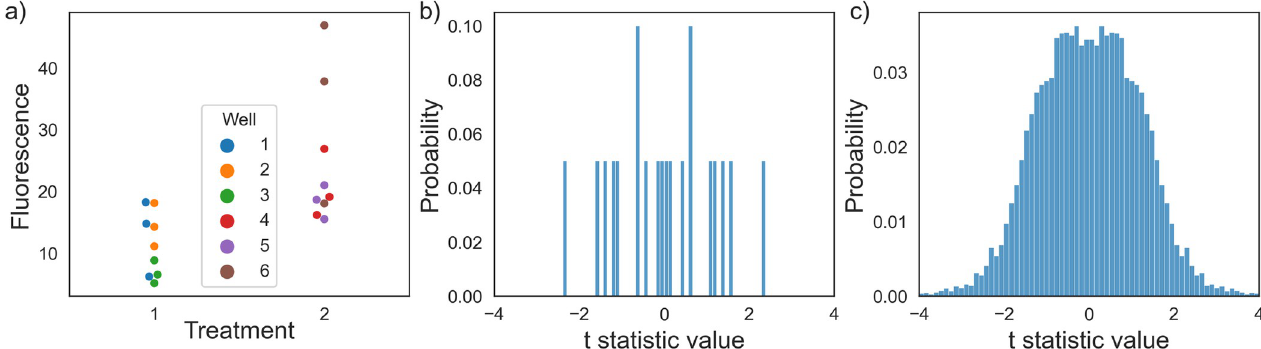
Fig 4. Hierarchical randomization uses bootstrapping to construct the empirical null distribution. (A) Simulated data corresponding to an experiment in Fig 2 . (B) A traditional cluster permutation test would only have twenty possible permutations, resulting in the smallest calculable two-tailed p-value being 0.1. (C) Hierarchical resampling constructs a full empirical null distribution, resulting in a p-value of 0.0429.